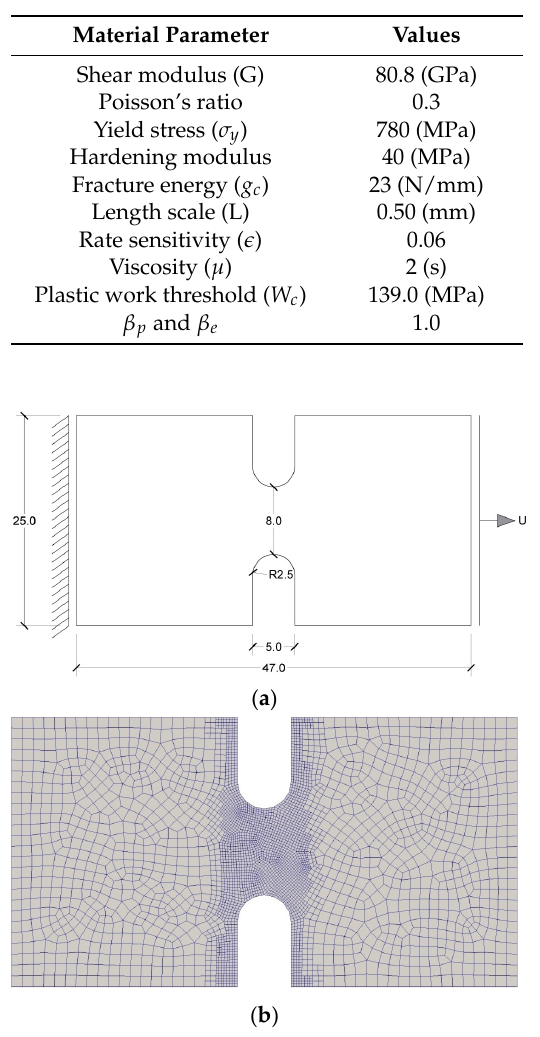
Table 3. Model parameters for the Ti6Al4V U-notched sample.